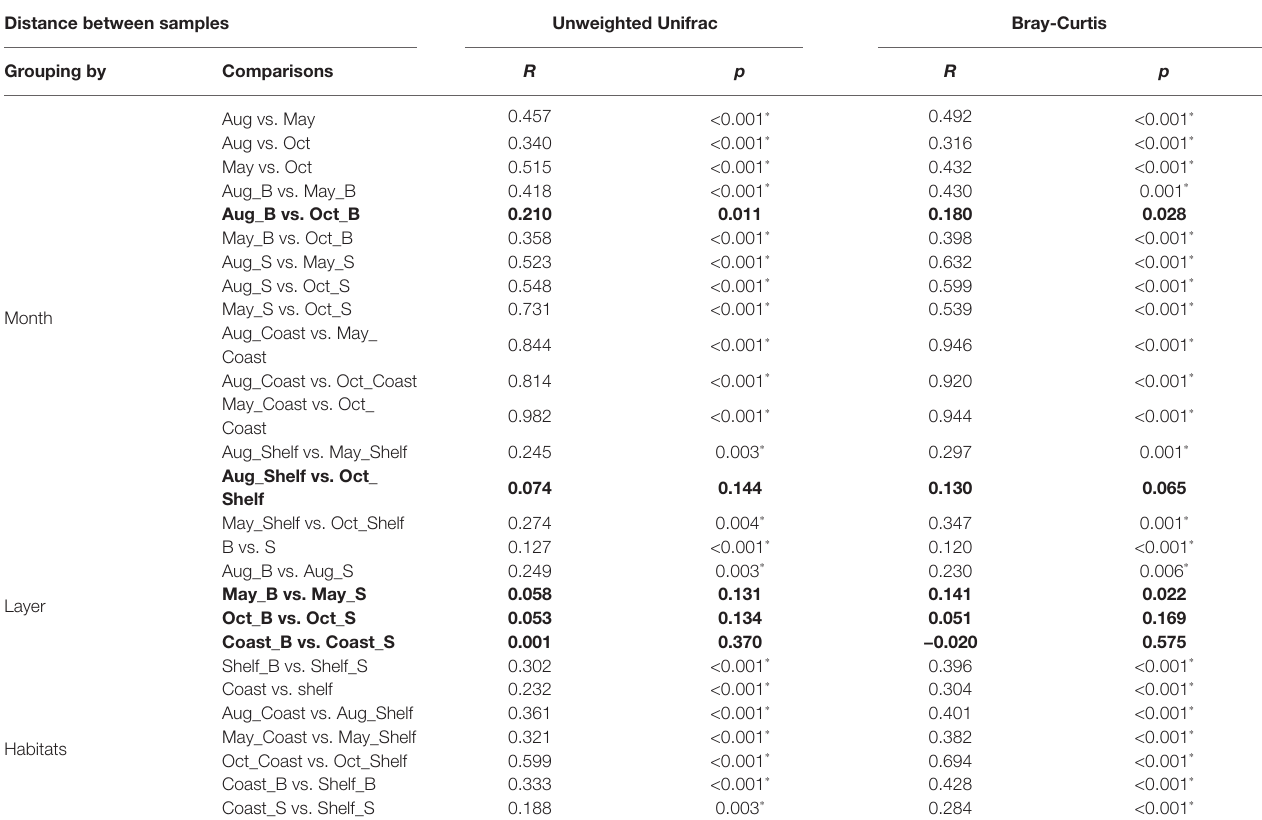
TABLE 2 | Analysis of similarities (ANOSIM) results of different comparisons based on months (May, August, and October), layers (B for bottom and S for surface), and habitats (coast and shelf) among the whole protist communities based on unweighed Unifrac distance and Bray-Curtis distance. Distance between samples Unweighted Unifrac Bray-Curtis Grouping